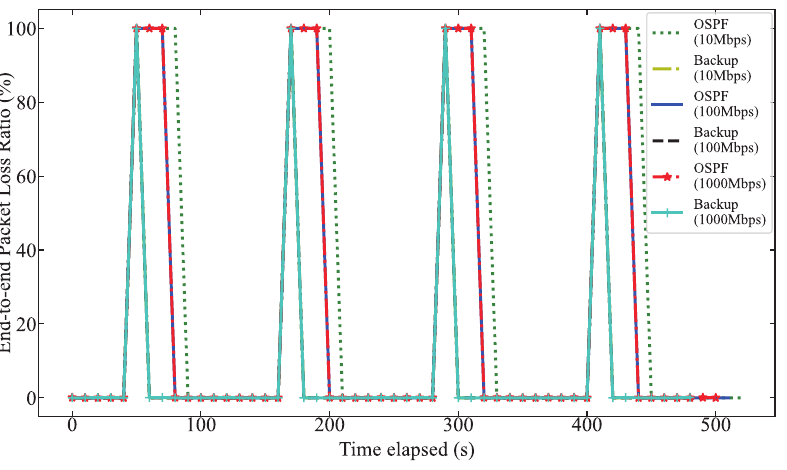
Figure 20. Packet loss ratio at different